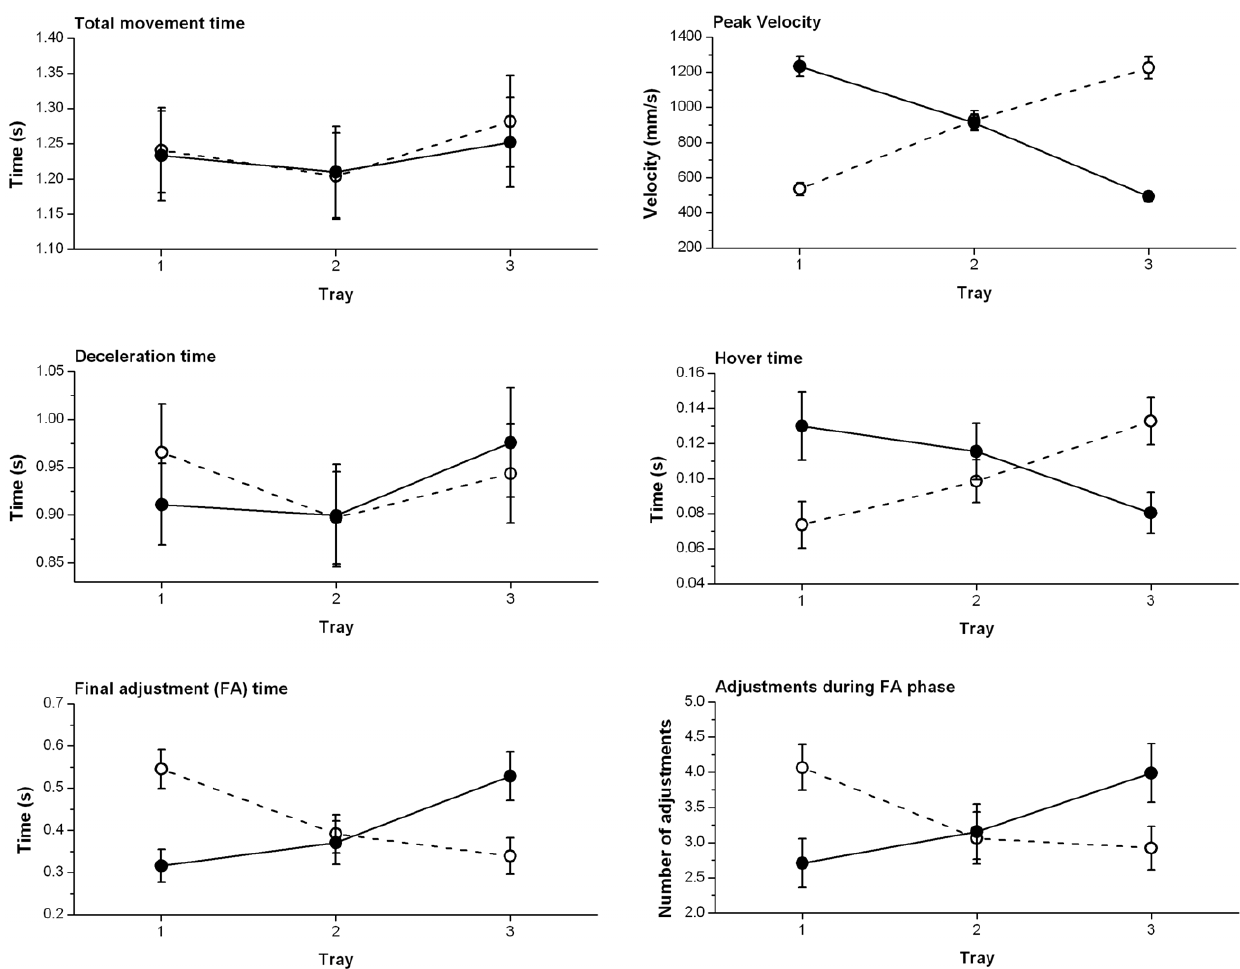
Figure 3. Significant hand 6 tray interactions. These plots show the dependent variables where significant hand 6 tray interactions were identified. For each plot the solid circles and solid line represent the right hand and the open circles and dotted line represent the left hand. Circles show the mean and error bars the standard error.